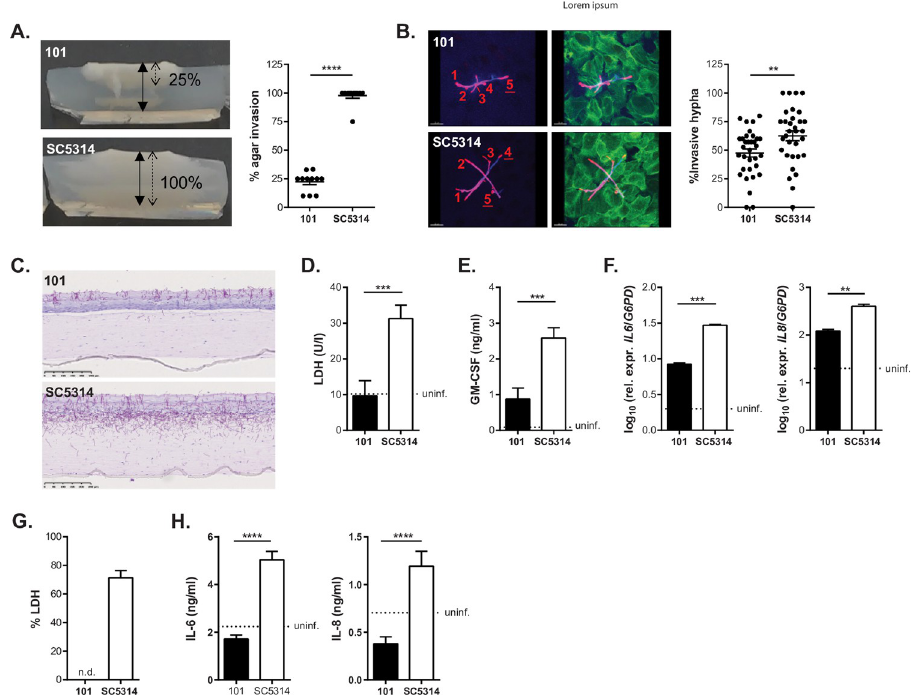
Fig 2. Isolate 101 is less invasive than SC5314. A. Representative images (left) and quantification (right) of the invasion depth of isolates 101 and SC5314 in YNB agar supplemented with BSA after 7 days of incubation at 37˚C and 5% CO 2 %. Agar invasion was calculated as the % of invasion depth (dotted arrow) relative to the overall thickness of the agar (solid arrow). Data were pooled from 4 independent experiments with 2–3 samples each. The mean ± SEM is indicated. Similar results were obtained with YNB agar supplemented with glucose or casamino acids. B. Representative images (left) and quantification (right) of TR146 cell monolayers incubated with isolate 101 or SC5314 for 4 hours at 37˚C and 5% CO 2 . Extracellular fungal parts were stained with an anti- Candida antibody (red), full fungal elements were visualized by calcofluor white staining (blue), and keratinocytes were stained with phalloidin (green). The counted number of total hyphae (red numbers) and of invasive hyphae (underlined red numbers) are indicated on the representative images. Each symbol in the quantification is the % invasion per field analysed with an average of 8 hyphae per field (a total of 32 fields were analysed per isolate with 240 hyphae for SC5314 and 283 hyphae for 101). The mean ± SEM is indicated for each group. Data were pooled from 2 independent experiments. C.-E. Reconstituted human epidermis (RHE) was infected with isolate 101 or SC5314 (bottom) for 24 hours. C shows PAS- stained histology sections. Scale bar = 250 μ m. Cellular damage was assessed by LDH release assay in D , GM-CSF concentrations were determined in the supernatant by ELISA in E , and IL-6 and IL-8 transcript levels were quantified by RT-qPCR in F . Bars are the mean+SD of 4 ( D , E ) or 2 ( F ) replicate wells from a single experiment. G.-H. Monolayers of TR146 keratinocyte were infected with isolate 101 or SC5314 for 24 hours. Epithelial cell damage was assessed by LDH release assay in G , and IL-6 and IL-8 cytokine levels were quantified in the supernatant by ELISA in H . Bars are the mean+SD of 4 replicate wells. Data are representative of at least 2 independent